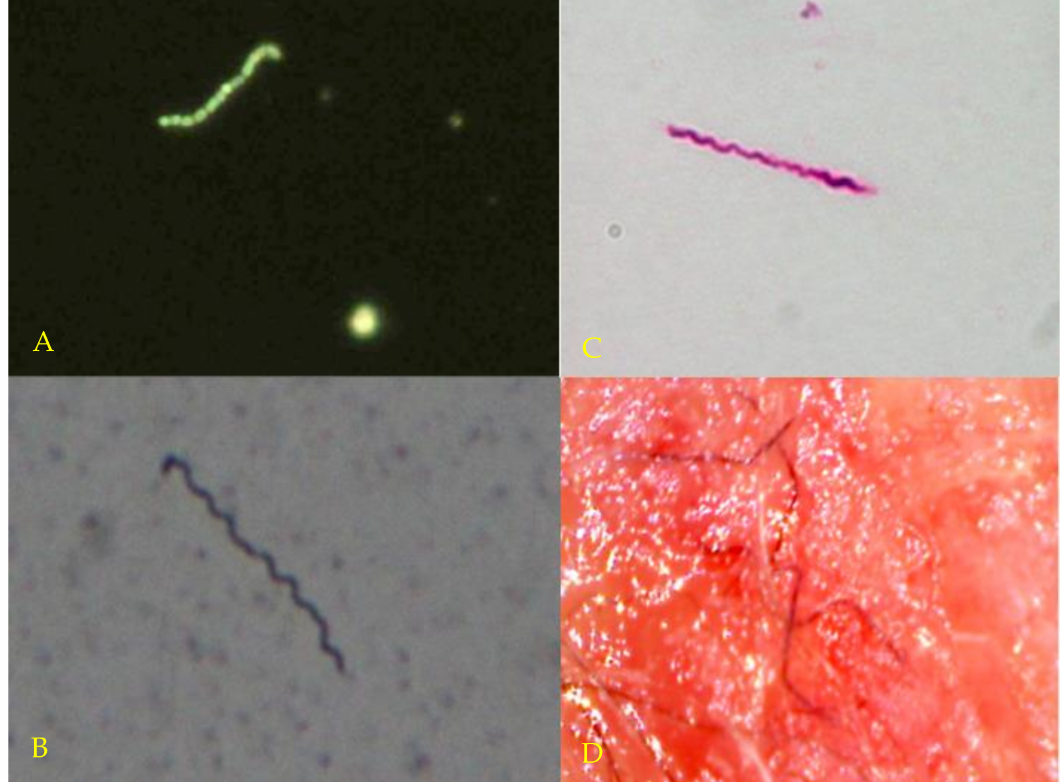
Figure 1. ( A ) (Top left): Darkfield microscopy of blood culture showing live spirochete and spherules. Magnification 400 × . ( B ) (Bottom left): Dieterle silver stain of culture fluid from Case 10 showing live spirochetes. Magnification 1000 × . ( C ) (Top right): Borrelia immunostain of culture fluid from Case 9 showing live spirochetes. Magnification 1000 × . ( D ) (Bottom right). Typical dermal filaments from patient with Morgellons disease. Magnification 100 ×